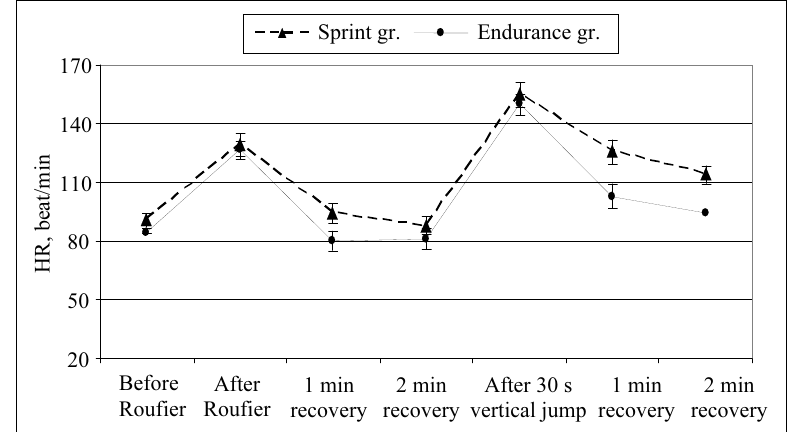
Figure 1. Dynamics of HR during dosed and maximal exercise test